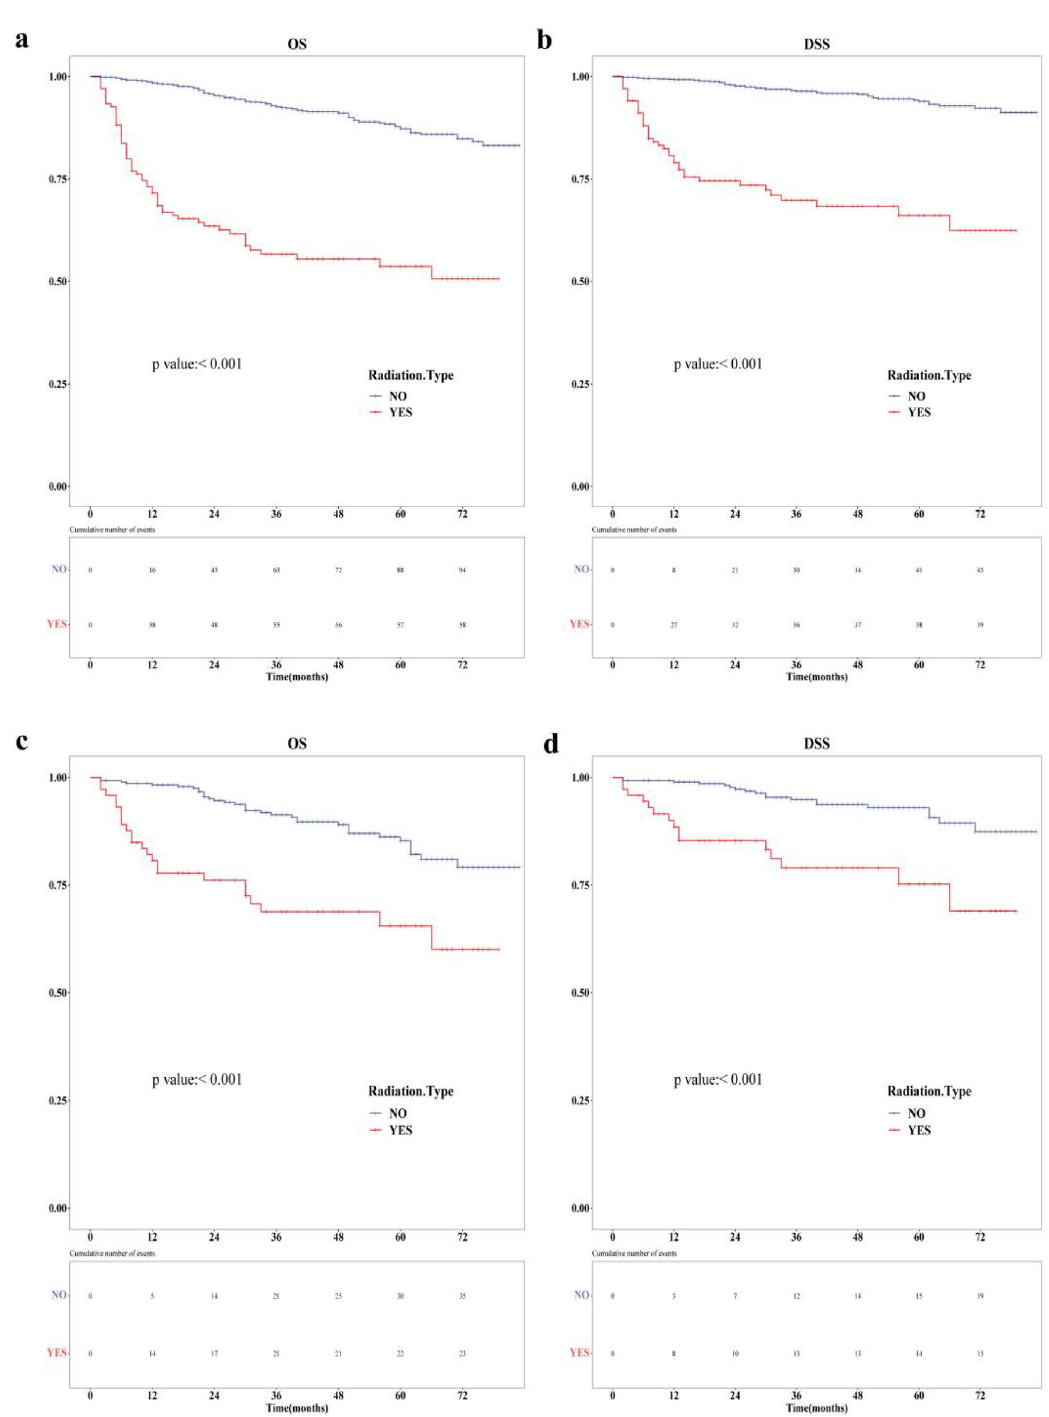
Figure 1. ( a ) Before propensity score-matched Kaplan–Meier analysis: overall survival as a function of EBRT. ( b ) Before propensity score-matched Kaplan–Meier analysis: disease-specific survival as a function of EBRT. ( c ) After propensity score-matched Kaplan–Meier analysis: overall survival as a function of EBRT. ( d ) After propensity score-matched Kaplan–Meier analysis: disease-specific survival as a function of